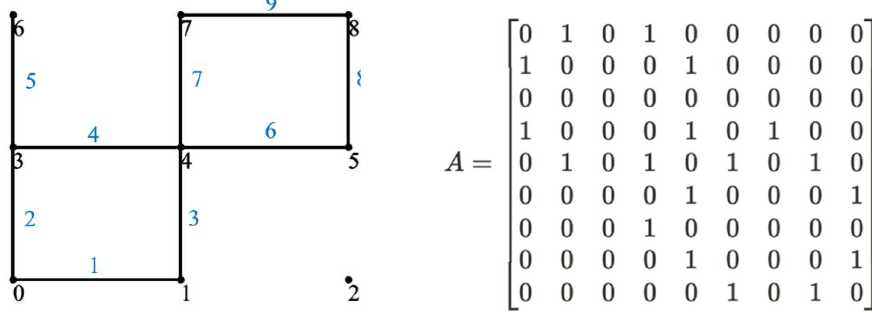
Figure 3. Adjacency Matrix of the 3 × 3 Lattice Converter Shown.